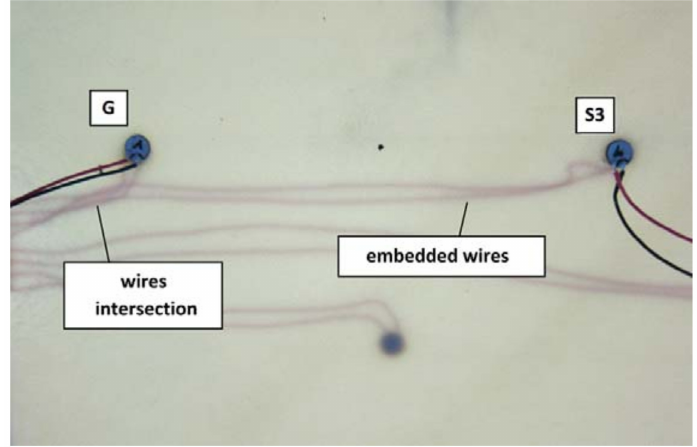
Figure 14. Embedded wires